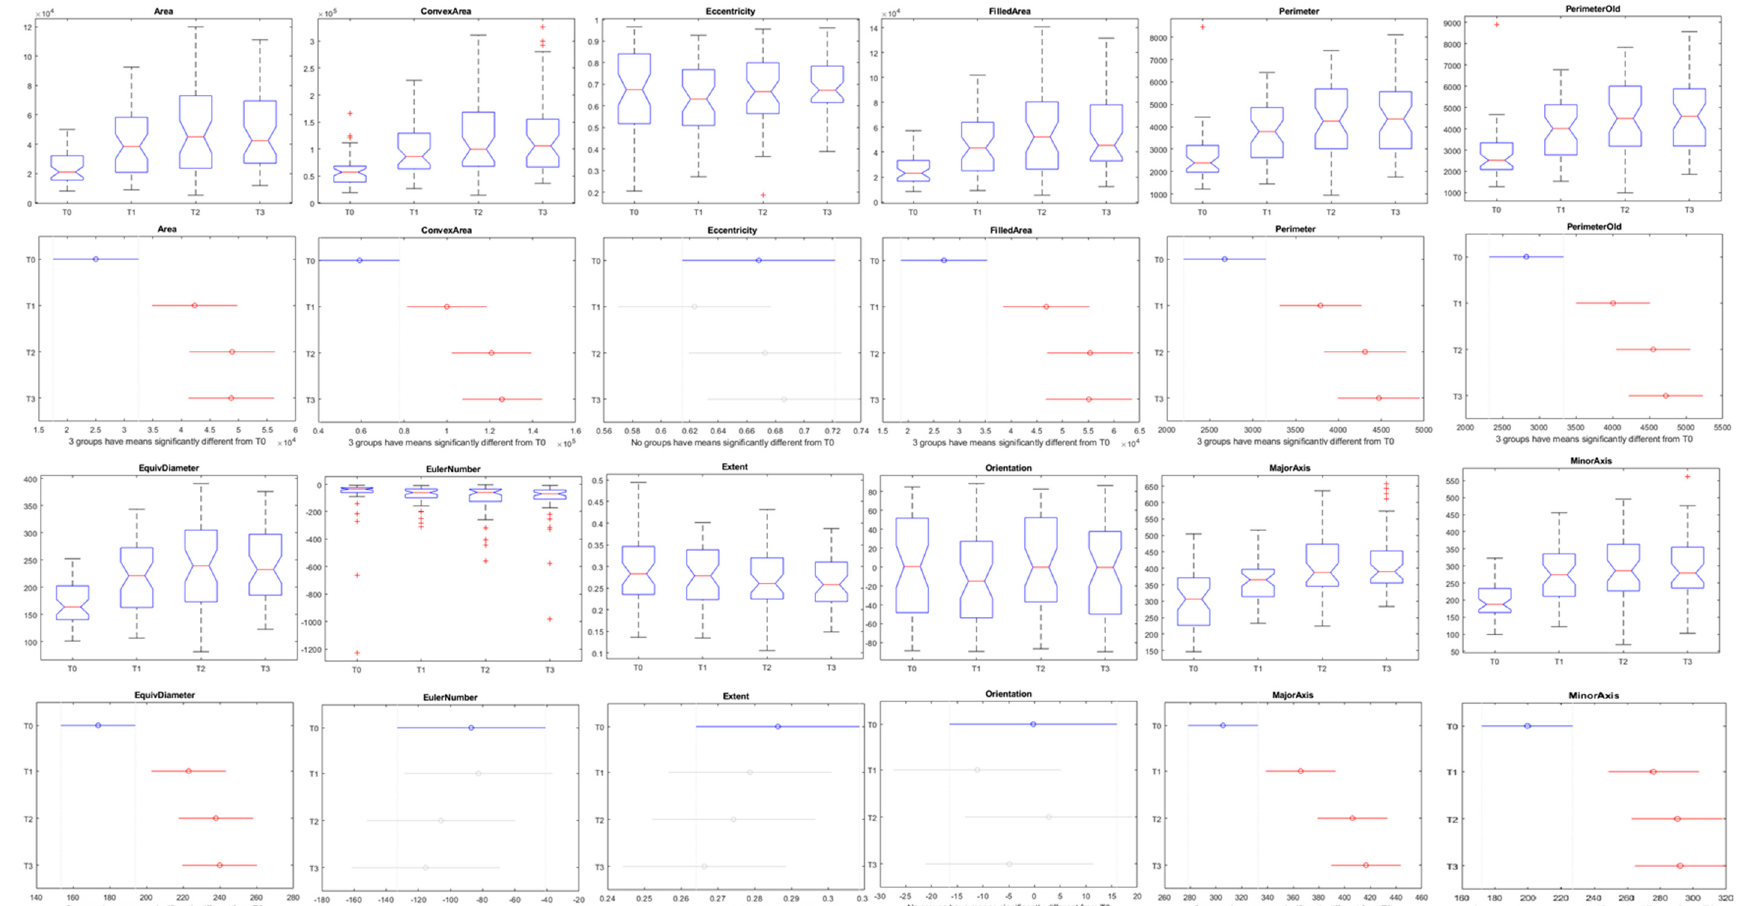
Figure 9. Boxplots and Tukey Test with 99% of probability using all data (50 days) representing morphological parameters of tomato plants with different levels of organic fertilization. T0, T1, T2, and T3 were the four groups of plants treated with different amounts of fertilizer and vermicompost (see Section 2).